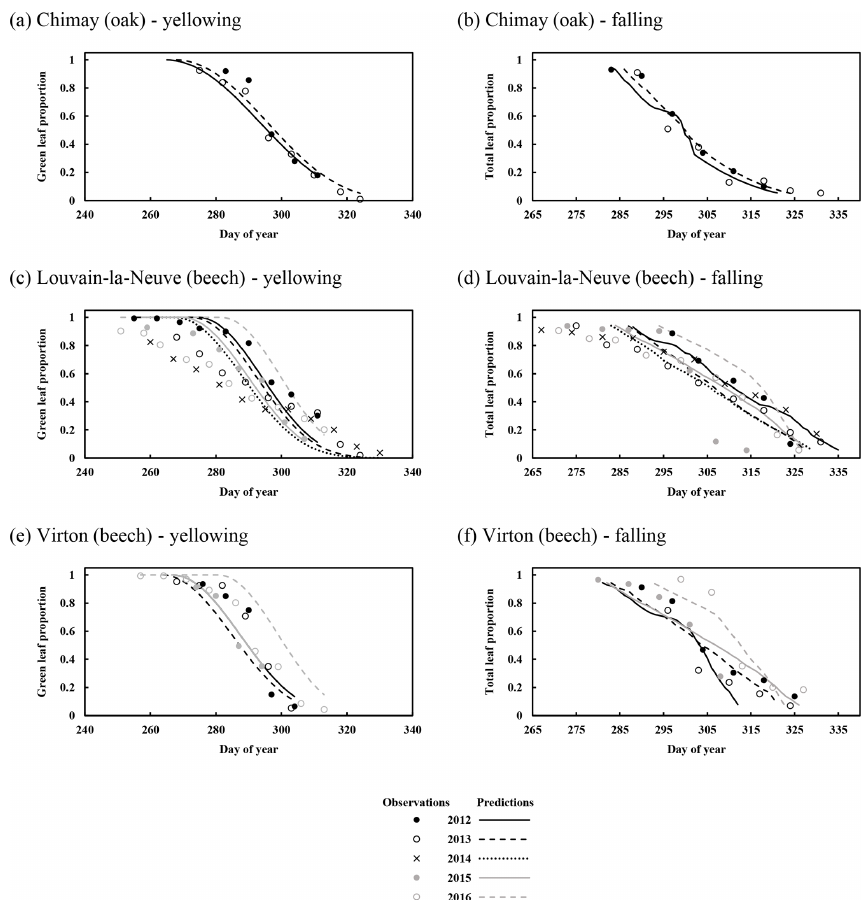
Figure 4. Observed and predicted temporal dynamics in leaf yellowing and in leaf fall in Chimay, Louvain-la-Neuve and Virton (data from 2012–2016). Yellowing is represented by the decrease in green leaf proportion (a, c, e) and leaf fall by the decrease in total leaf proportion (b, d, f)